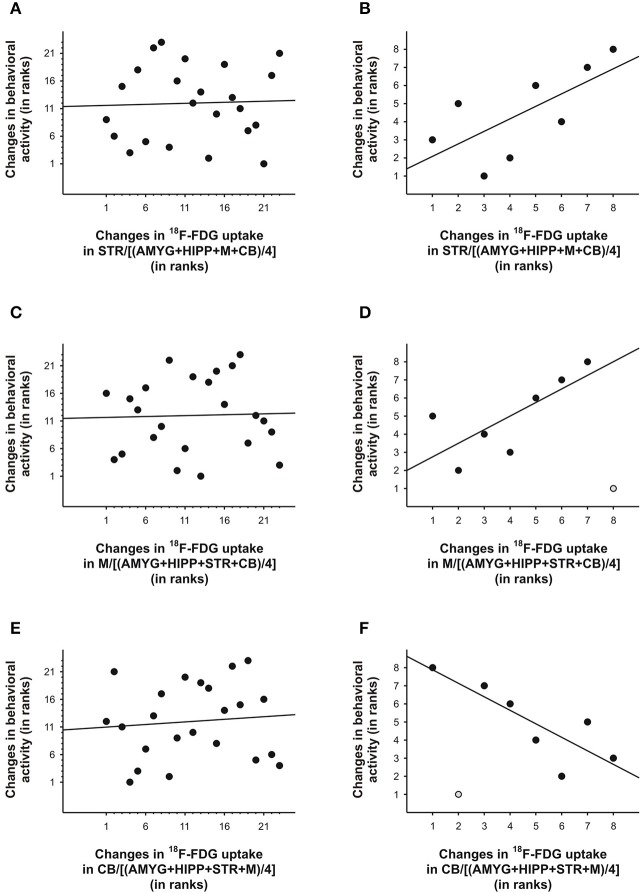
Changes in 18F-FDG uptake correlated with changes in behavioral activity across scan 1 in rat. We correlated changes in 18F-FDG uptake, i.e., differences between successive 5min time bins, in the (A,B) striatum (STR), (C,D)motor cortex (M), and (E,F) cerebellum (CB) relative to a reference region (the average uptake in a combination of four ROIs) with changes in behavioral activity for the same time frames. When all 5min time frames (n = 23) were included for analysis (A,C,E), changes in 18F-FDG uptake did not significantly predict changes in behavioral activity across time. By contrast, for the time frames (n = 7–8) near the times of the 18F-FDG injections (B, D, F), changes in uptake in STR,M, and CB explained a large proportion of the variance in behavioral activity. The data are represented as ranks. Rank 1 indicates the largest decrease, whereas the highest rank indicates the largest increase between any of two successive 5-min-long time frames. When an outlier (light gray) was present (D, F), the regression line was fitted to the remaining data.